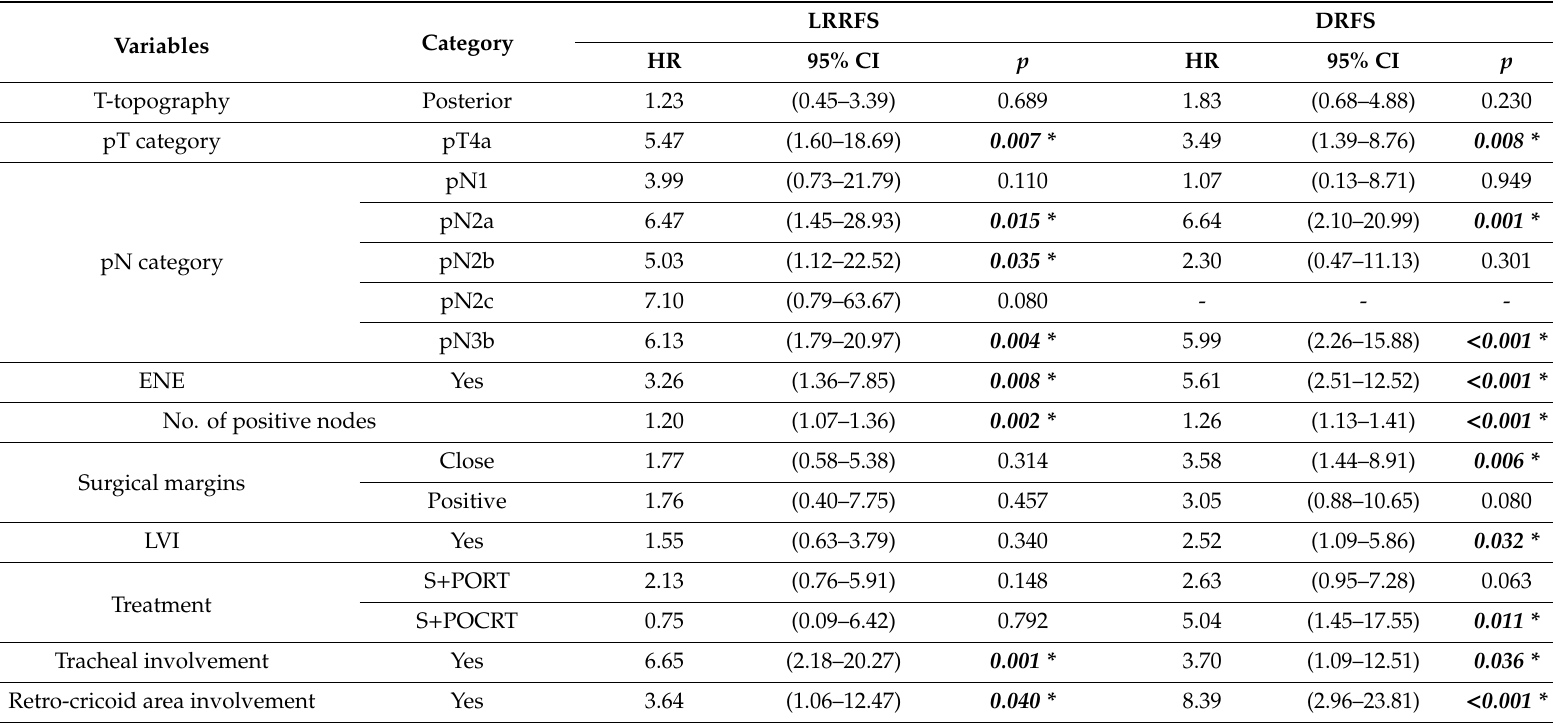
Table 3. Univariable loco-regional recurrence-free survival (LRRFS) and distant recurrence-free survival (DRFS) analysis (significant variables for at least one outcome are reported, while additional variables analyzed are reported in Table